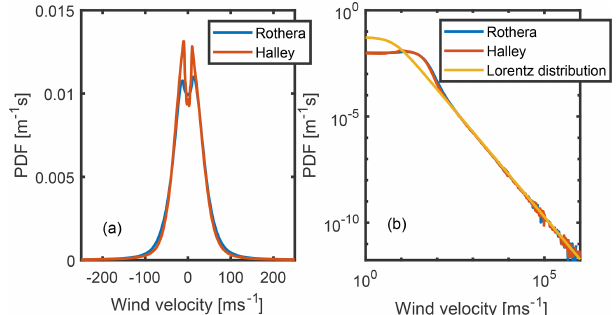
Figure 3. (a) Probability distribution function (PDF) of the com- bined (zonal and meridional) wind velocities at Halley (red) and Rothera (blue) for the entire data set. The double hump is due to the tidal influence over the winds. (b) The same distributions plotted on a log–log scale to illustrate the long tails of the distributions, with a Lorentz distribution ( b = 5 . 7) fitted to the data beyond ∼ 300ms − 1